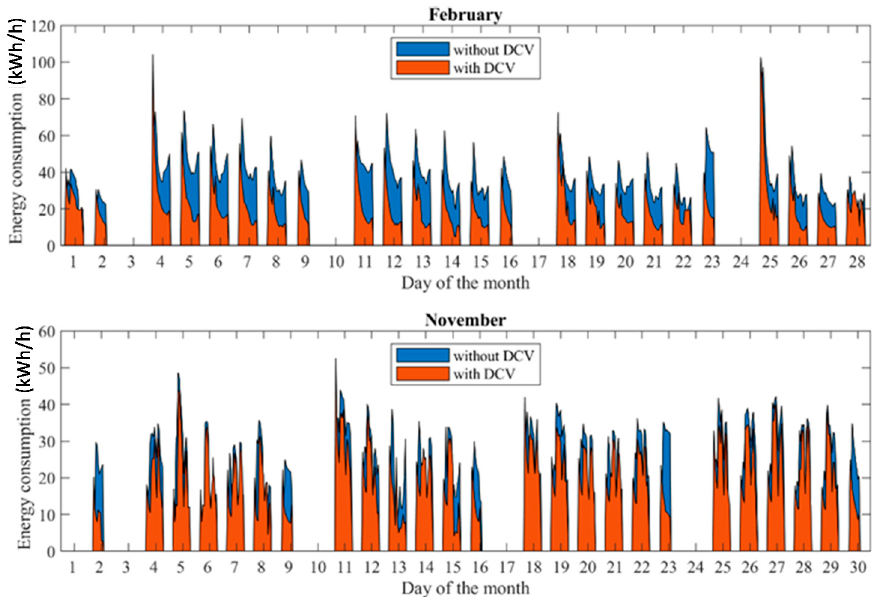
Figure 9. Energy consumption of Building A in February and November with and without DCV.